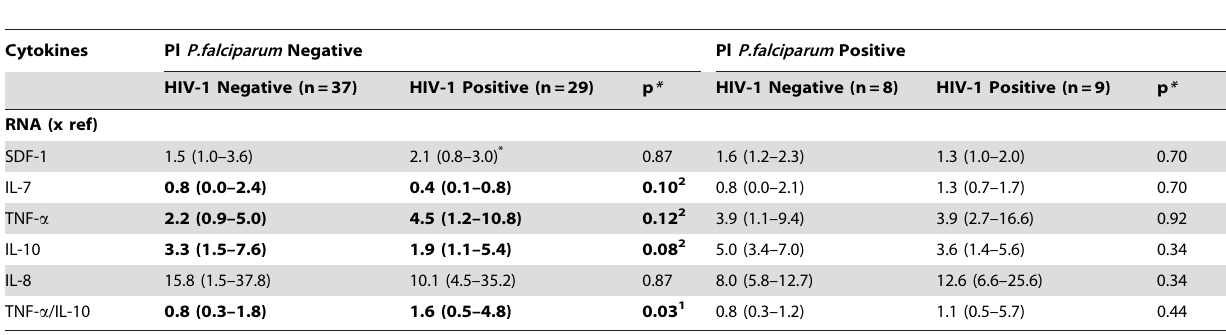
Table 6. Difference in Placental cytokine expression levels (RNA) between HIV-1 negative and positive women in relation to Placental Plasmodium falciparum